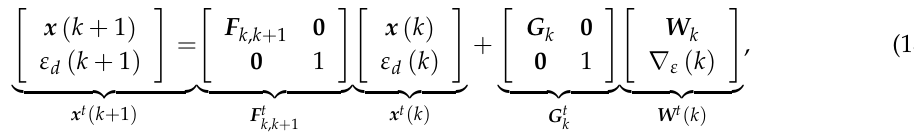
Figure 5. Illustration of the SINS/WSN FATCI system.